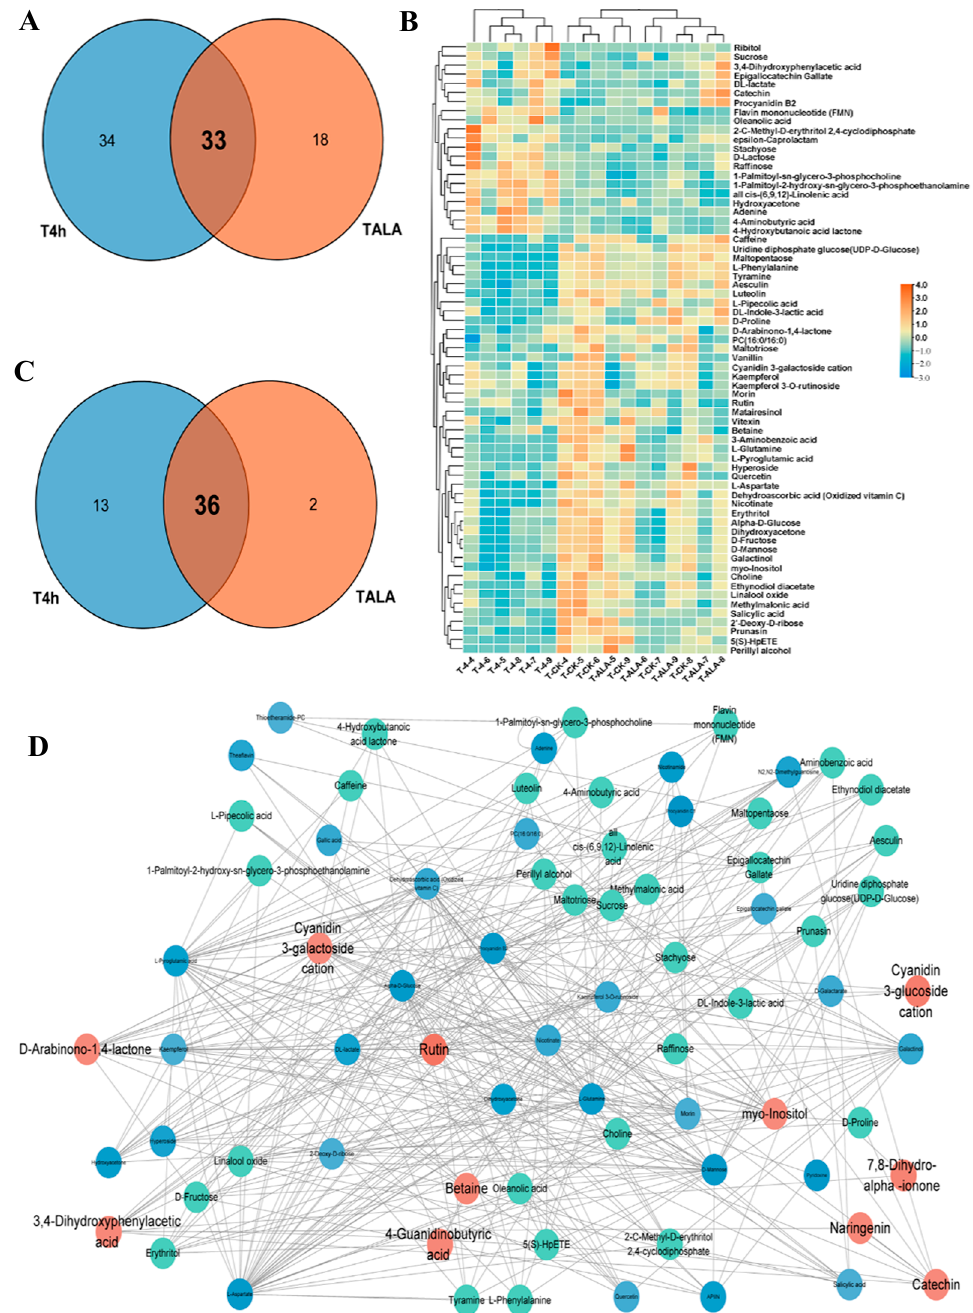
Figure 3. Overlapping of ALA- and cold-induced metabolic alterations. ( A ) Venn diagram of all significantly differential metabolites in T4h vs. CK and TALA vs. CK comparisons. Counts in blue and red denote metabolites from T4h vs. CK and TALA vs. CK, respectively. The shaded area denotes the differential metabolites shared by both comparisons. ( B ) Heatmap displaying the ALA-induced alterations in relative levels of metabolites associated with cold stress. The overlapping area represents the common pathways shared by both comparisons. ( C ) Venn diagram showing the overlapping enriched pathways in the T4h vs. CK and TALA vs. CK comparisons. ( D ) Topological correlation network of metabolites associated with ALA treatment and cold